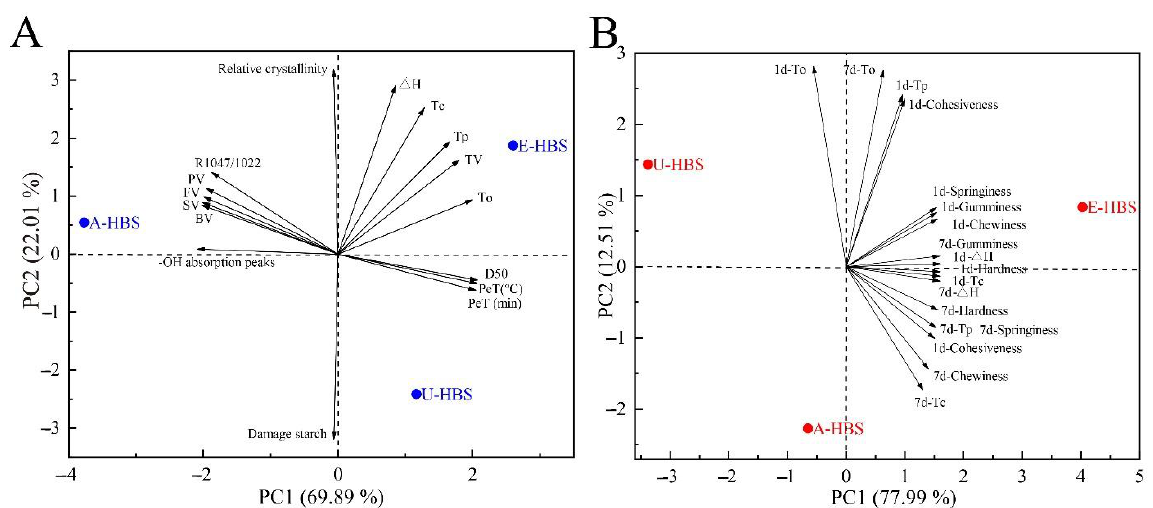
Figure 7. Principal component analysis — Correlation analysis based on different extraction methods with gelatinization ( A ) and retrogradation ( B ) properties. A-HBS: HBS extracted by alkali method; U-HBS: HBS extracted by ultrasonic method; E-HBS: HBS extracted by enzymatic